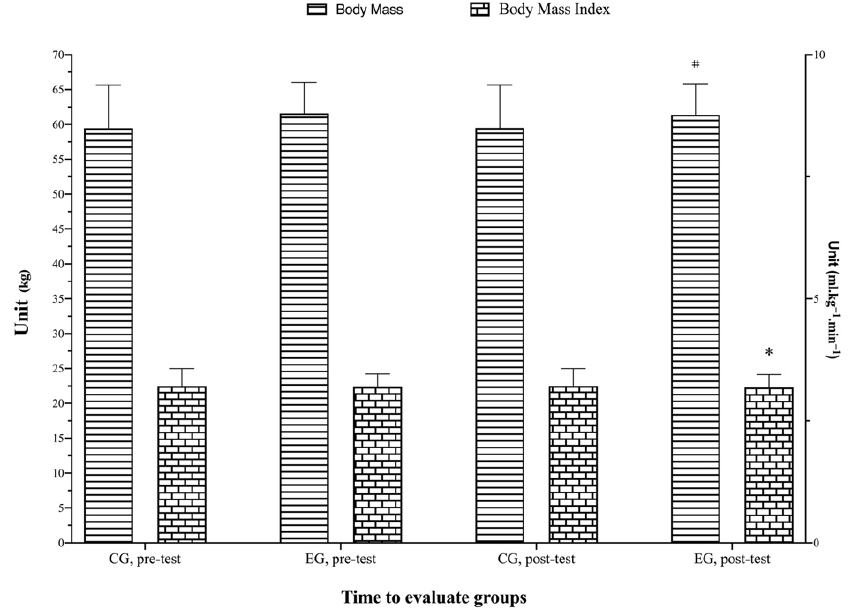
Figure 6. Change in body mass and body mass index variables assessment for each group and assessment stage. * Represents a statistically significant difference compared to the pre-test with the superiority of the EG ( p < 0.05). # Represents a statistically significant difference compared to the pre-test with the superiority of the CG ( p < 0.05). EG: experimental group; CG: control